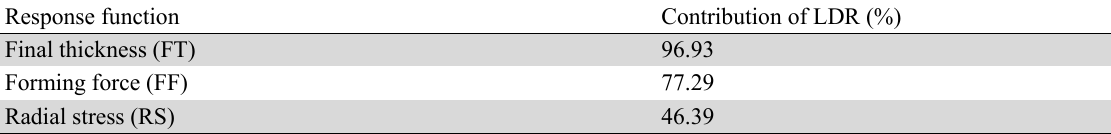
The percentage contribution of LDR (first rank parameter) Response function Contribution of LDR (%)